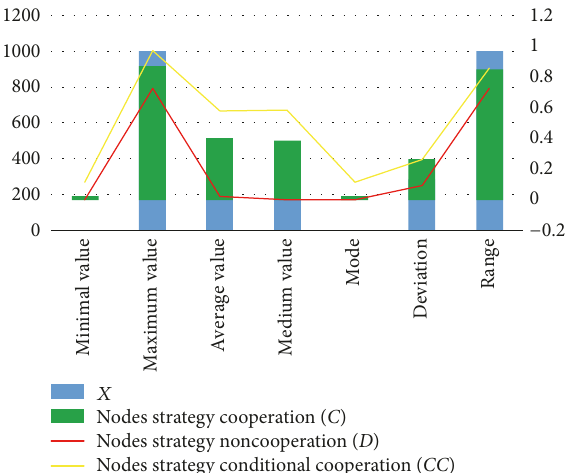
Figure 26: The state of population when 𝑋 = (0, 1000, 492.5, 491.5, 0, 294.7,